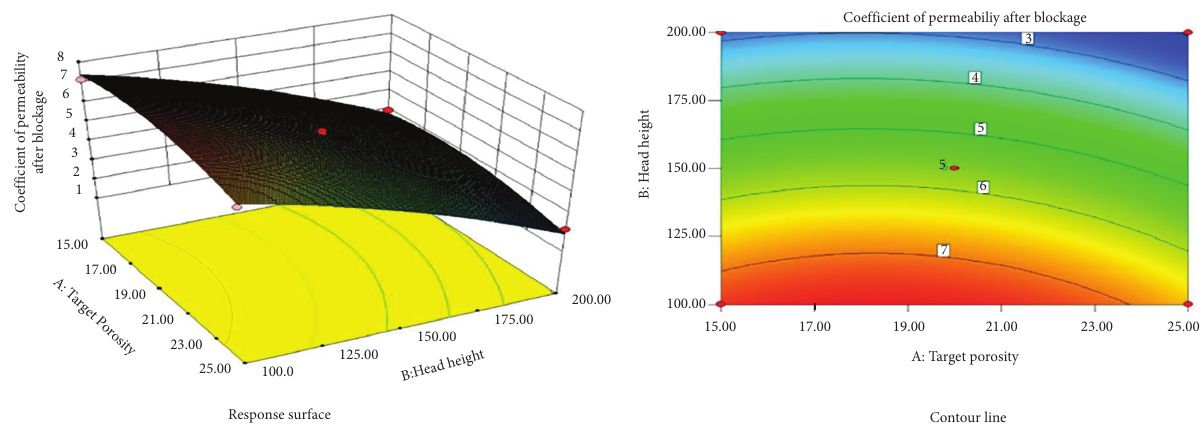
Figure 11: Influence of target porosity A and head height B on the permeability coefficient after clogging.